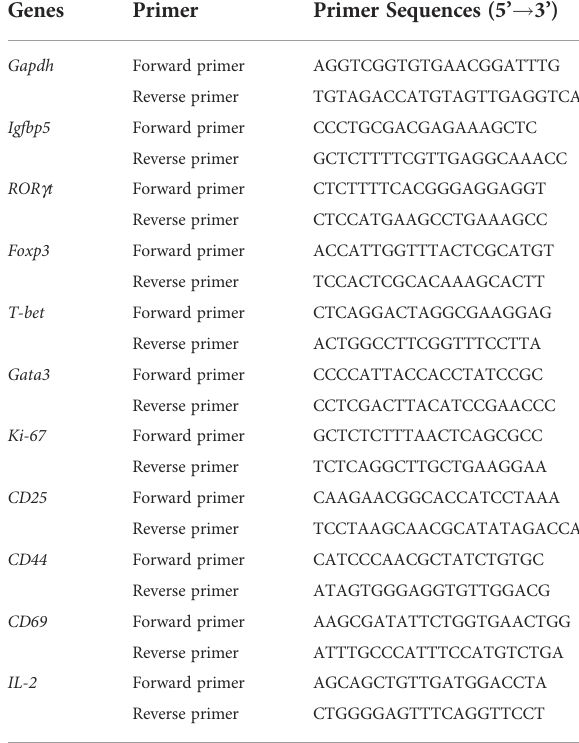
TABLE 1 Primers used in the real-time PCR